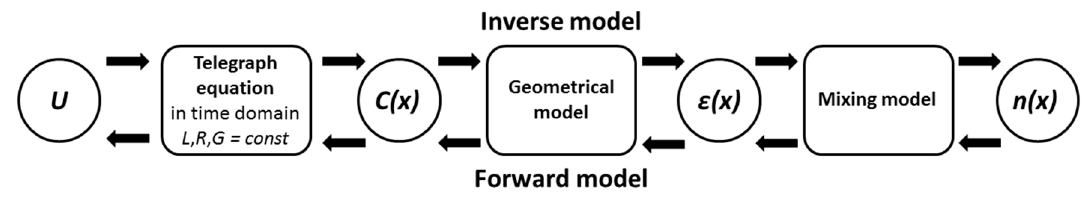
Figure 3. Schematic diagram of the generic inversion method to obtain the porosity profile from the measured TDR signal at the cell input.